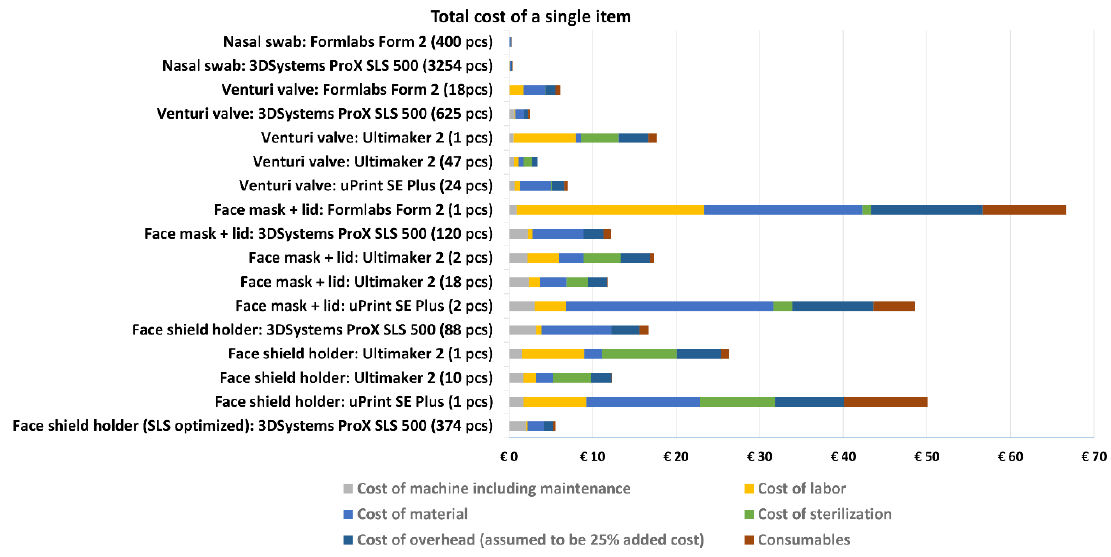
Figure 2. Total cost of producing a single item as a function of different 3D printers, batch sizes (shown in parentheses), and cost components.